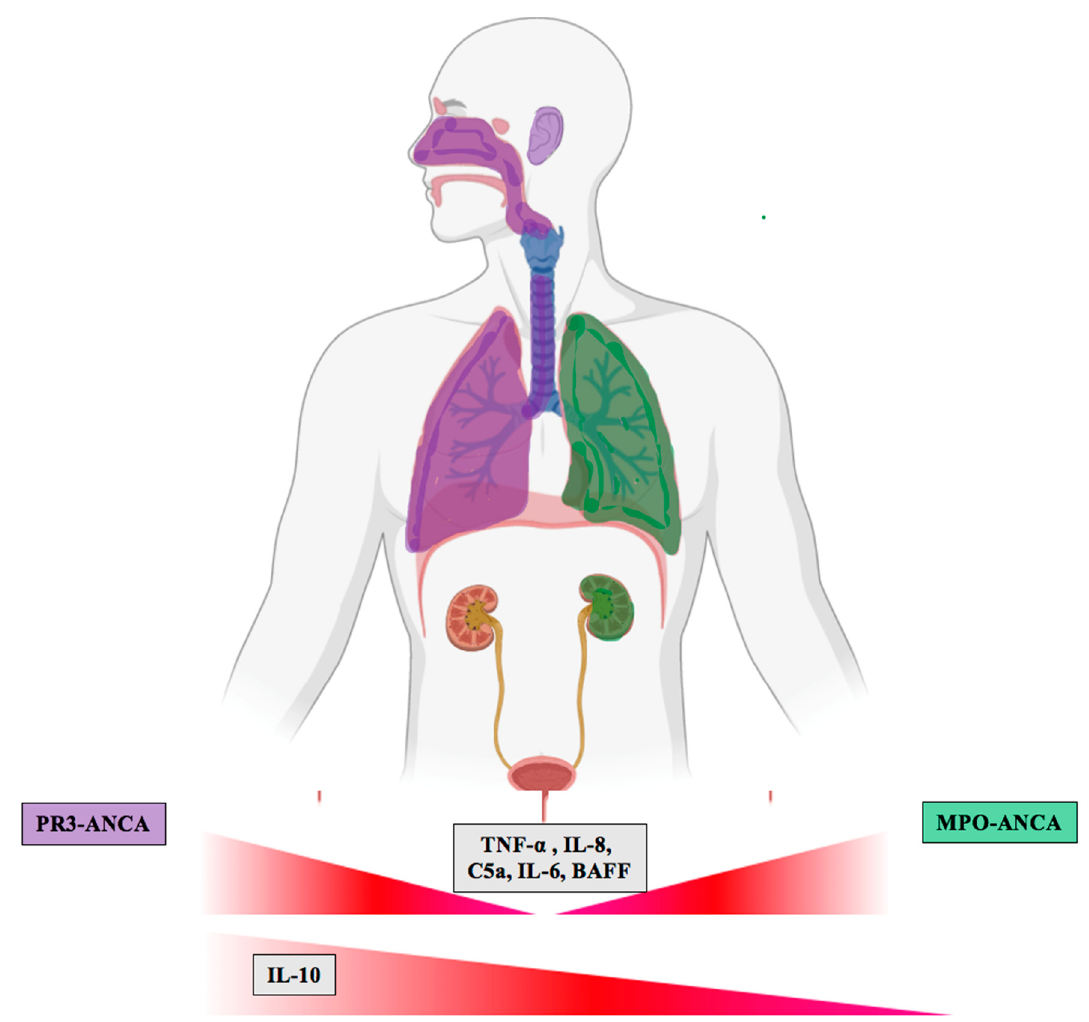
Figure 2. Phenotypes of ANCA serotypes. PR3-ANCA (purple) affects the ear nose and throat (ENT), the upper and lower respiratory tract and the kidneys in around 50–60% of cases, while MPO-ANCA (green) primarily affects the lungs and kidneys. Tumor necrosis factor (TNF)- α , C5a, interleukin (IL)- 6, IL-8, and B cell activating factor (BAFF) are elevated in both PR3- and MPO-ANCA. IL-10 is elevated only in PR3-ANCA and is decreased in